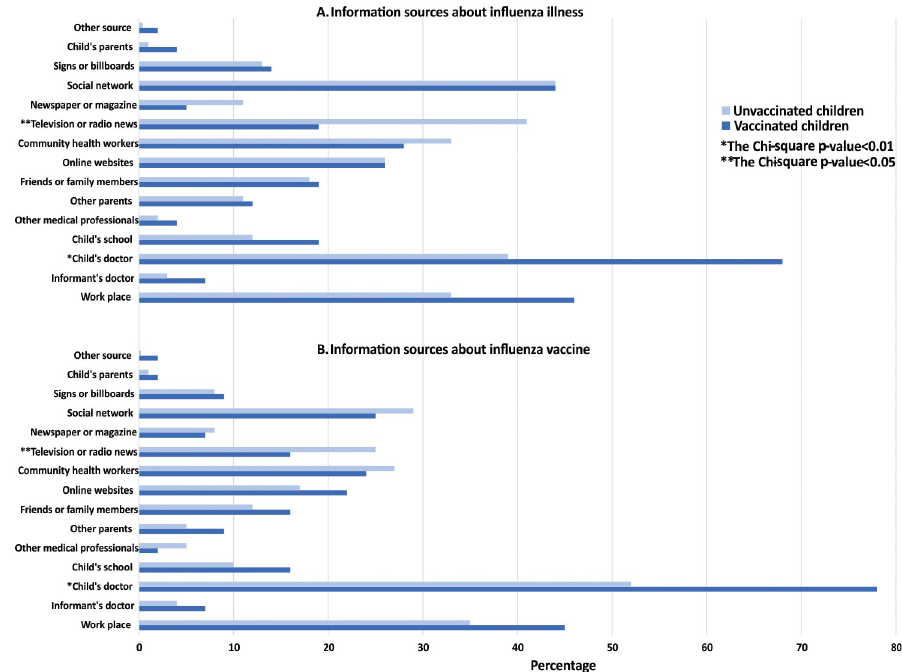
Fig 1. Information sources about influenza illness and influenza vaccine for children. For source of information regarding influenza, only those who knew of influenza were included and for source of information regarding influenza vaccine, only those who knew of influenza vaccine were included. All sources that apply could be selected.